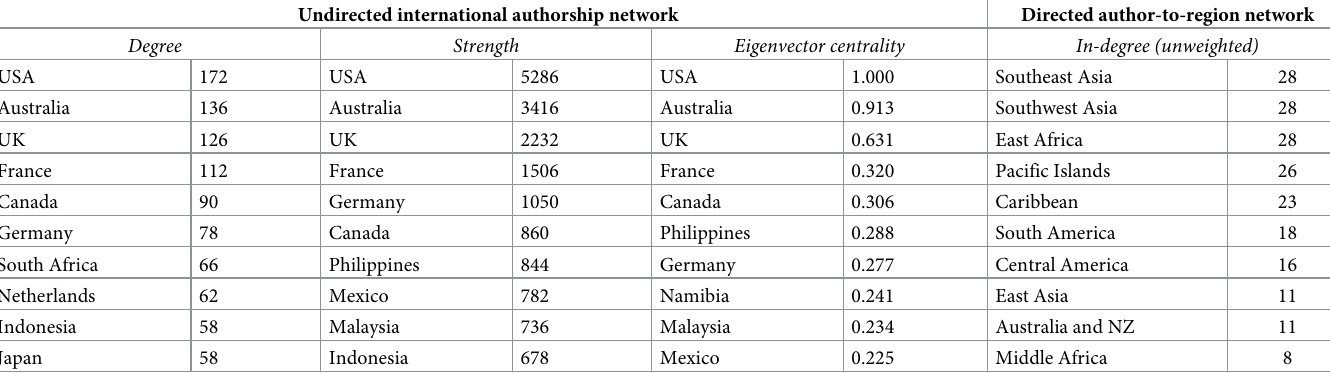
Table 4. Node centrality metrics for each network analysis. Only the top 10 countries (nodes) are shown for undirected authorship network analysis. All twelve regions are shown in the directed author-to-region network. Full lists for undirected authorship network analysis can be found in S5 and S6 Tables. Undirected international authorship